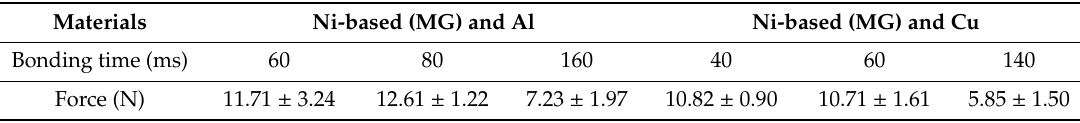
Table 2. The force to tear the samples